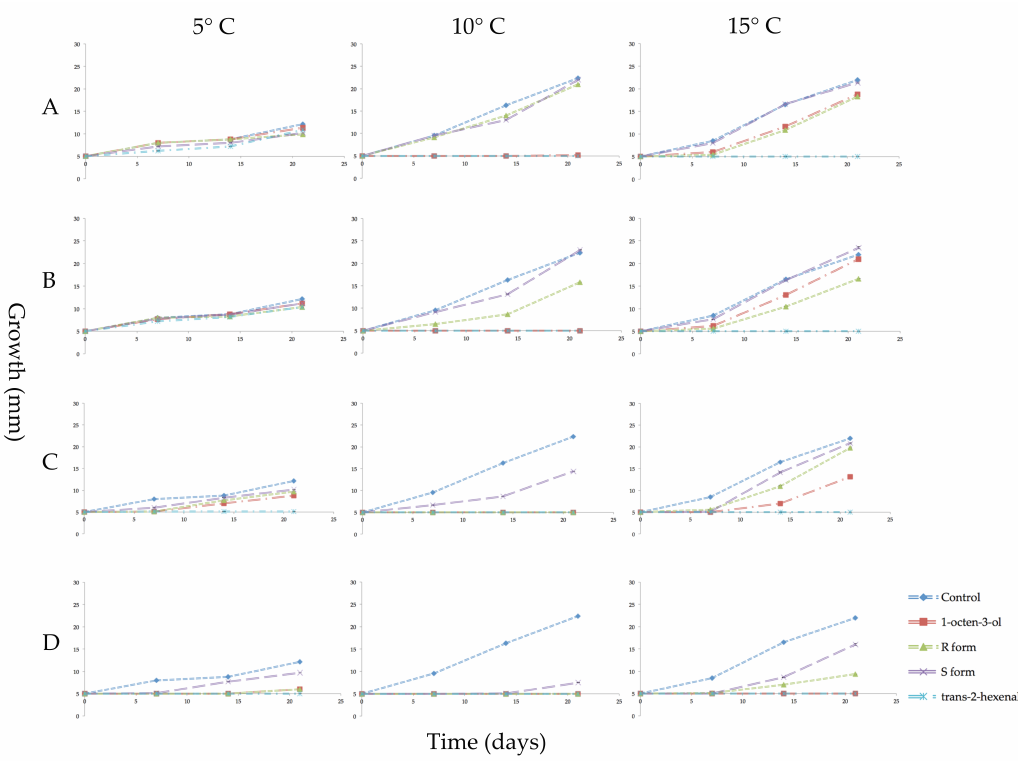
Figure 4. Growth in millimeters (mm) of mycelial plugs of Pseudogymnoascus destructans which were subcultured in ambient air for 3 weeks at 5, 10, or 15 ◦ C after prior exposure for 3 weeks to vapors of racemic 1-octen-3-ol, ( R )-( − )-1-octen-3-ol ( R form), ( S )-(+)-1-octen-3-ol ( S form), or trans -2-hexenal. Error bars indicate the standard error of the mean. VOC treatments as follows: ( A ) 0.04 µ mol/mL of the three forms of 1-octen-3-ol or 0.05 µ mol/mL of trans -2-hexenal; ( B ) 0.08 µ mol/mL of 1-octen-3-ol or 0.1 µ mol/mL trans -2-hexenal; ( C ) 0.4 µ mol/mL 1-octen-3-ol or 0.5 µ mol/mL trans -2-hexenal; ( D ) 0.8 µ mol/mL 1-octen-3-ol or 1.0 µ mol/mL trans